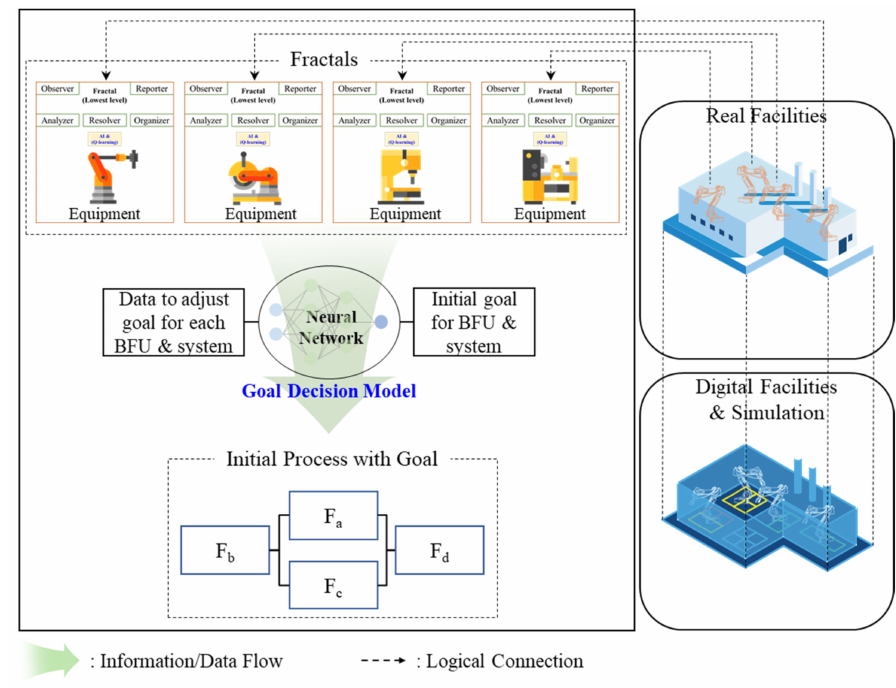
Figure 15. Goal decision model in